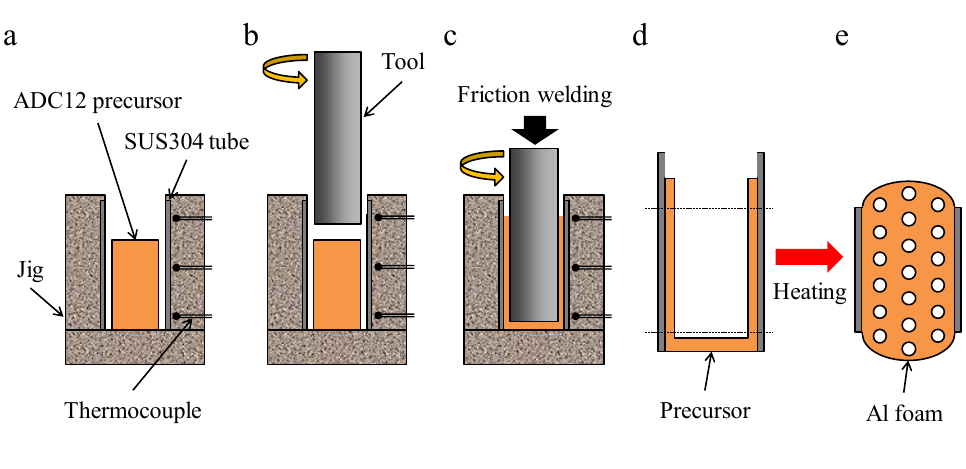
Figure 13. Schematic illustration of fabrication process of ADC12 Al foam-filled thin-wall SUS304 steel tube by friction